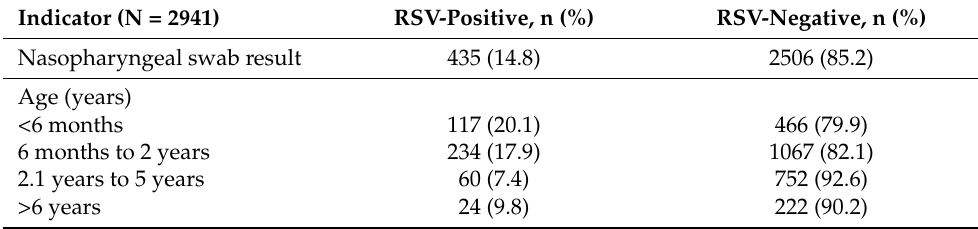
Table 1. Characteristics of the study